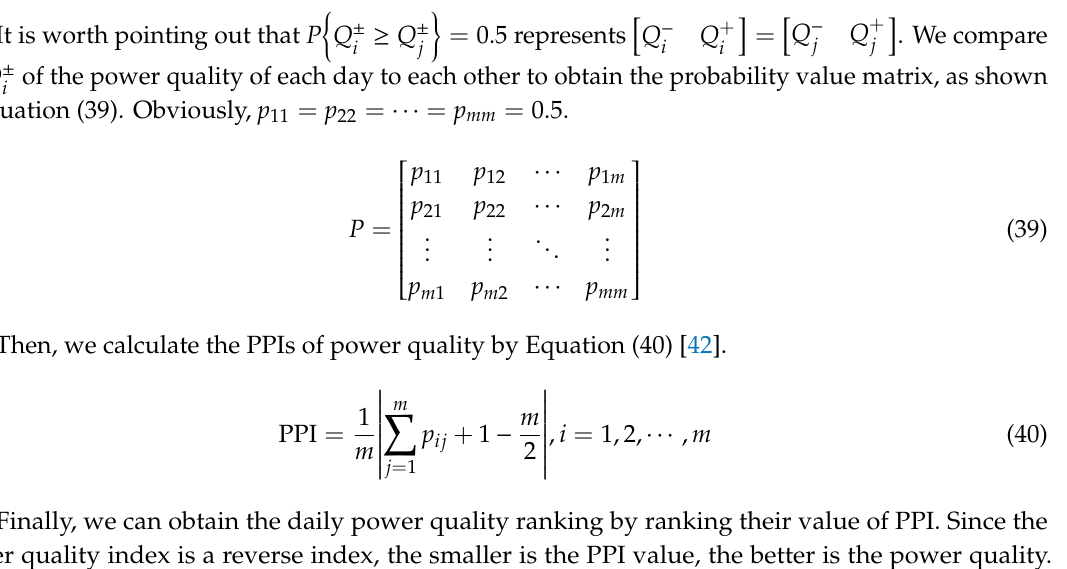
Table 5. Deviation values of measured data. Time